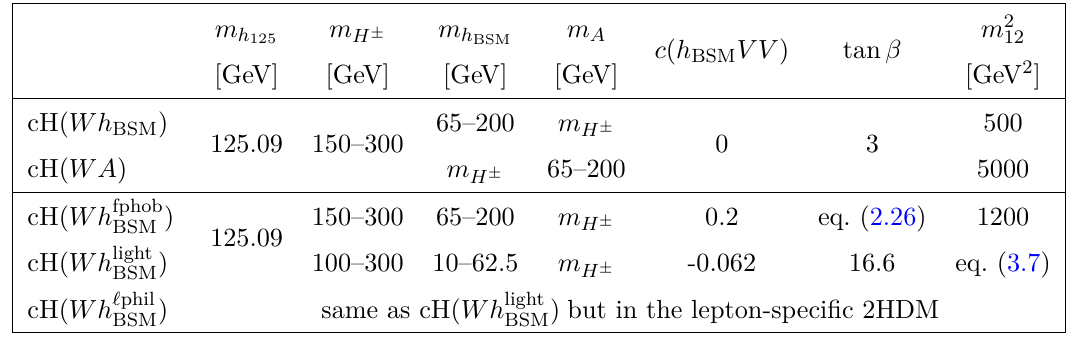
Table 5. Parameter choices in the five benchmark scenarios for the H ± → W ± φ ( φ = h BSM , A ) decay the 2HDM. All scenarios except cH ( Wh ‘ phil